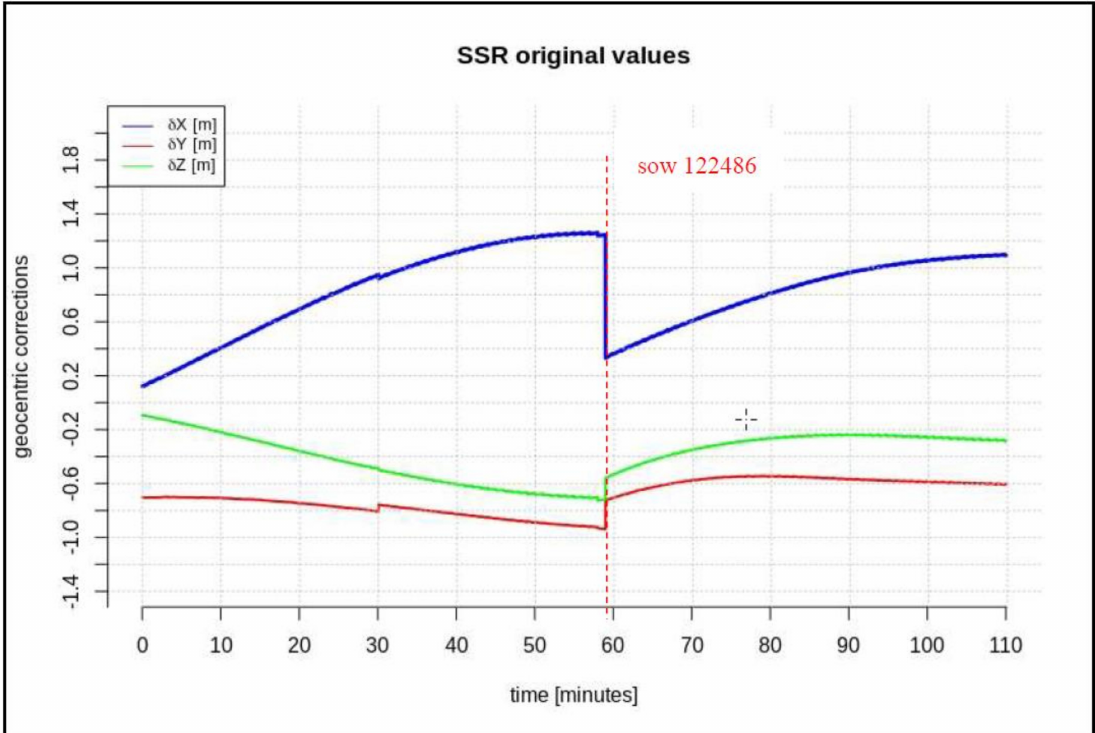
Figure 3. Time series of the geocentric corrections δ P of DOY 85, GPS